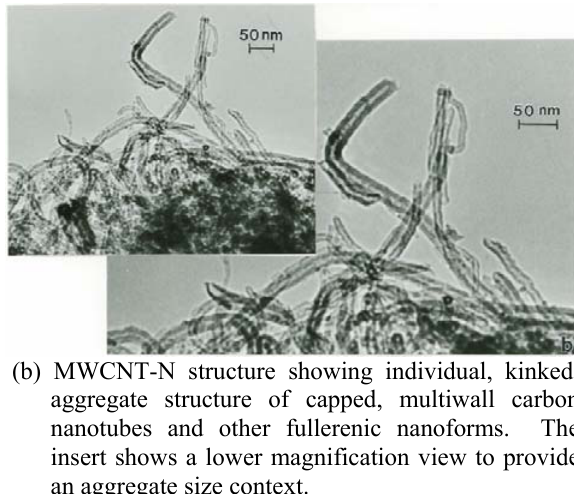
Figure 2: TEM bright-field image of MWCNT-R test sample